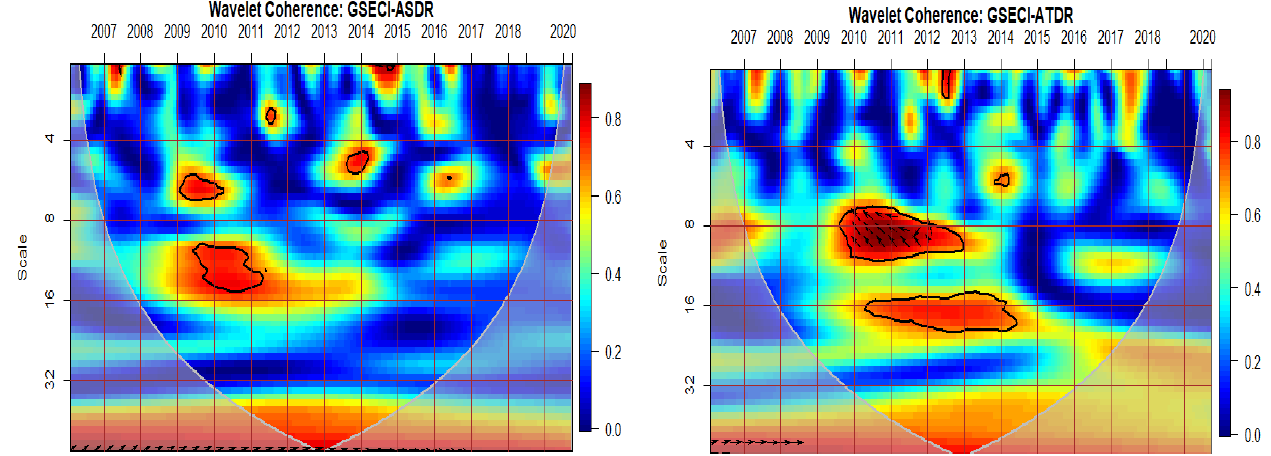
Figure 7. Comovements between GSECI and interest rates.